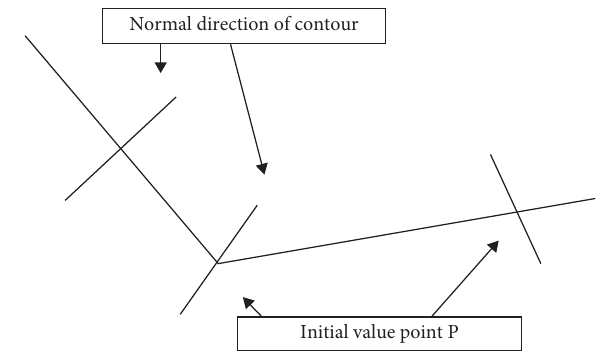
Figure 3: Contour of the target